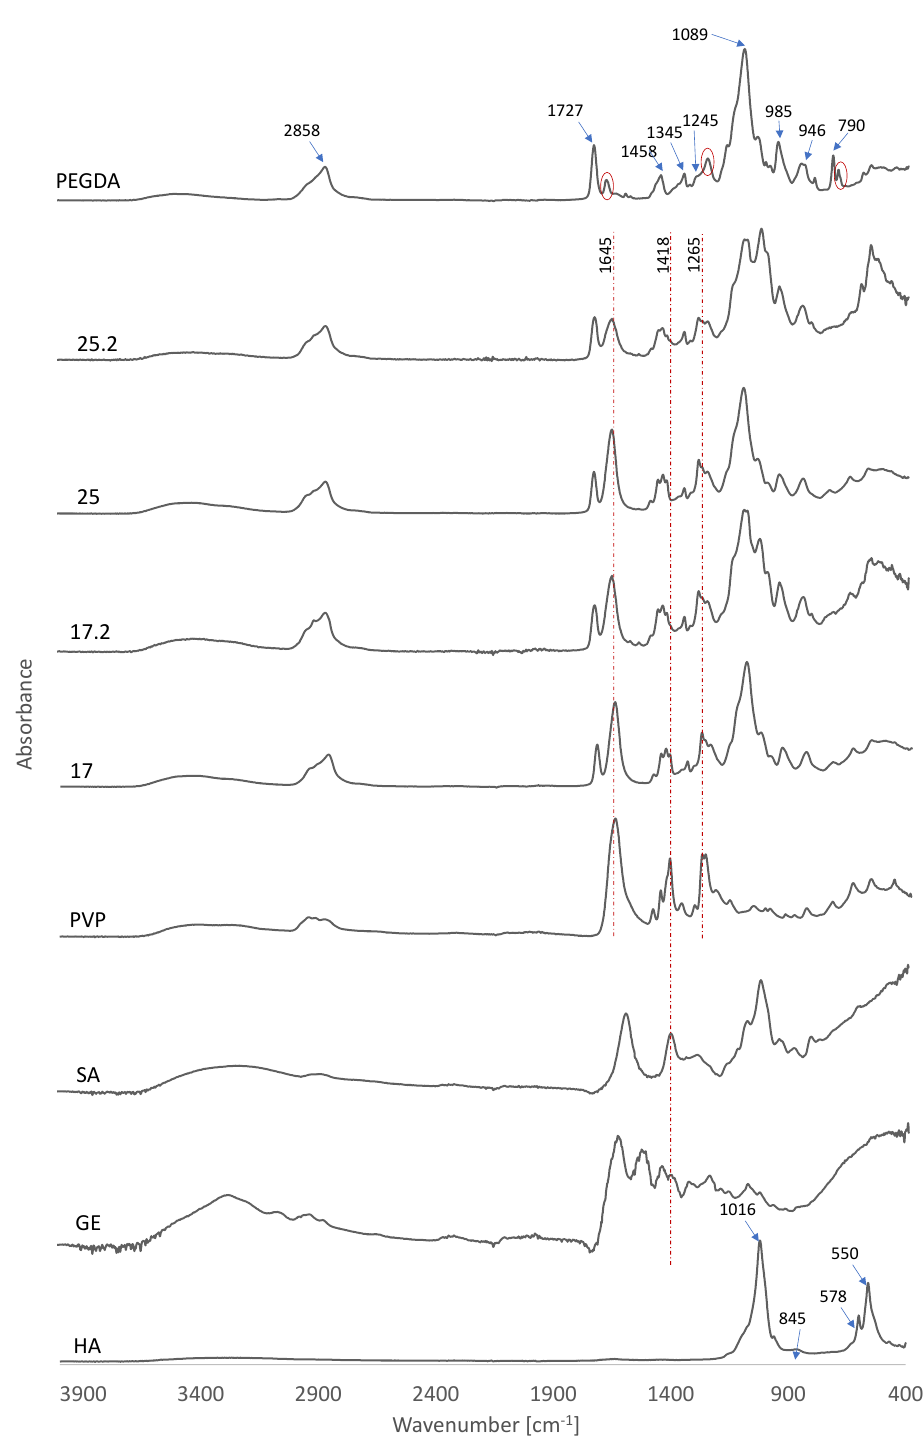
Figure 2. FTIR spectra of PEGDA, PVP, GE, SA, and composites.